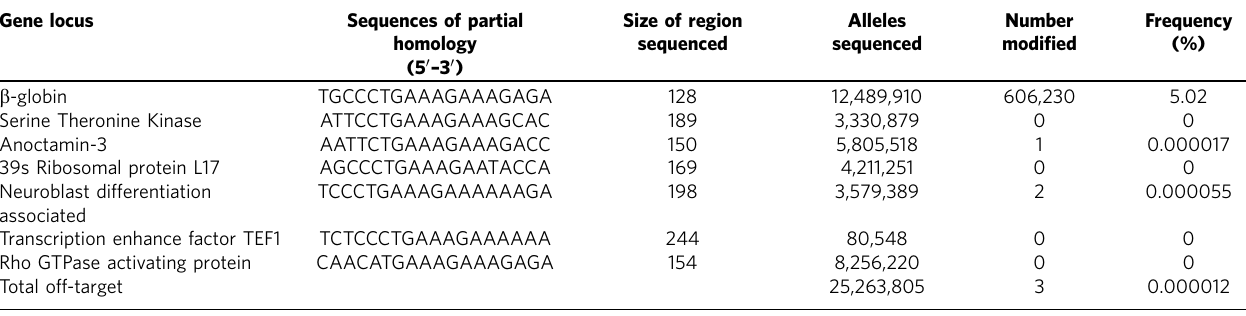
Table 3 | Deep sequencing analysis of targeted gene editing versus off-target effects in human CD34 þ haematopoietic cells following ex vivo treatment with SCF and g tcPNA4/donor DNA